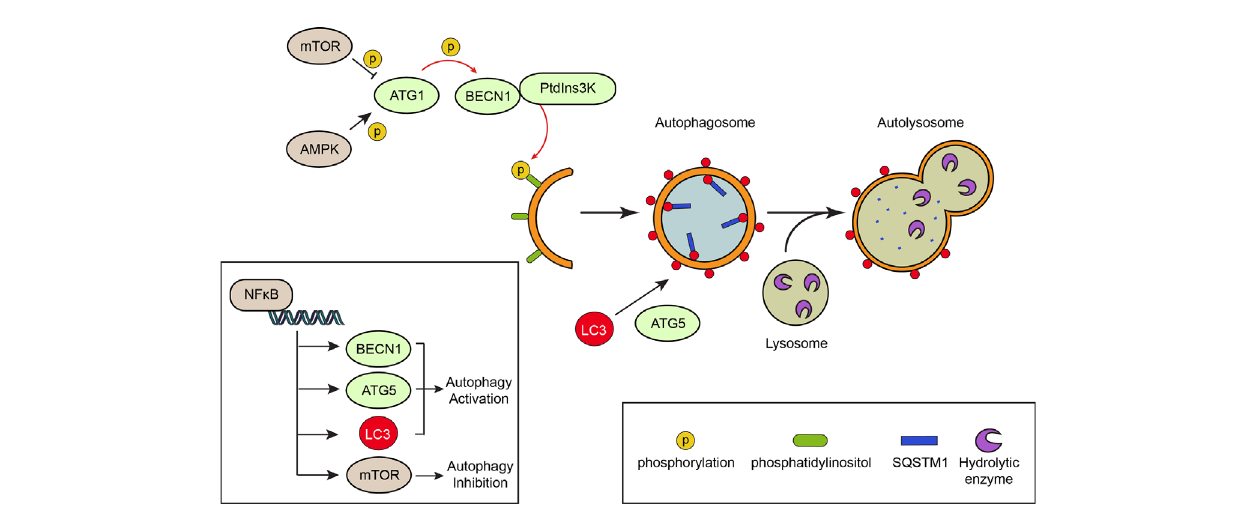
FIGURE 3 | The mechanism of autophagy. Autophagy is a degradation process that involves the formation of double membrane vesicles called autophagosomes. Canonical signaling pathways, such as activation of the nutrient deprivation sensor AMP-activated protein kinase (AMPK) or inhibition of the nutrient-full sensor mechanistic target of rapamycin (mTOR) activate autophagy-related protein 1 (ATG1) kinase by phosphorylation. This in turns phosphorylates the Beclin 1 (BECN1) protein, allowing formation of a PtdIns3K complex that phosphorylates the phosphatidylinositol of intracellular membranes. Formation of the autophagosomes implicates the elongation of the membranes and their decoration with LC3 molecules, a process that is assisted by the ATG5 protein. The material targeted for degradation (i.e. proteins and organelles) arrives to the elongating membrane of the autophagosome through “ receptors ” , like SQSTM1/p62, which binds polyubiquitinated proteins. Once the autophagosome is formed, it fuses with a lysosome that contains hydrolytic enzymes, leading to the degradation of the material enclosed within the autophagosome. The NF k B pathway is involved in transcriptional up-regulation of autophagy proteins such as BECN1, LC3 and ATG5, thereby promoting